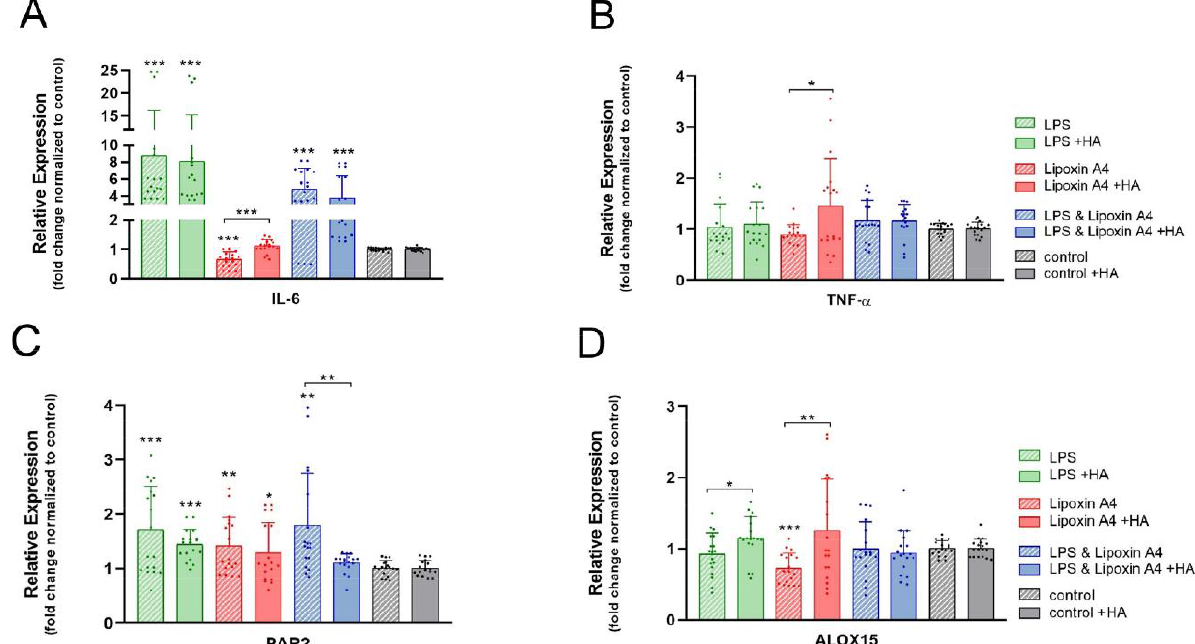
Figure 6. IL-6 ( A ), pro-inflammatory markers TNF- α ( B ) and PAR2 ( C ) and pro-resolution marker ALOX15 ( D ) stimulated with LPS, Lipoxin A4 or both molecules compared to the control without stimulation. Stars indicate pairwise comparison probability in Student’s t test comparing tenocytes with or without inflammatory and pro-resolving stimulation. Stars above a line indicate pairwise comparison probability in Student’s t test comparing tenocytes with the same stimulation , but in a different culture medium (without or with HA): p < 0.05 (*), p < 0.01 (**) and p < 0.001 (***).